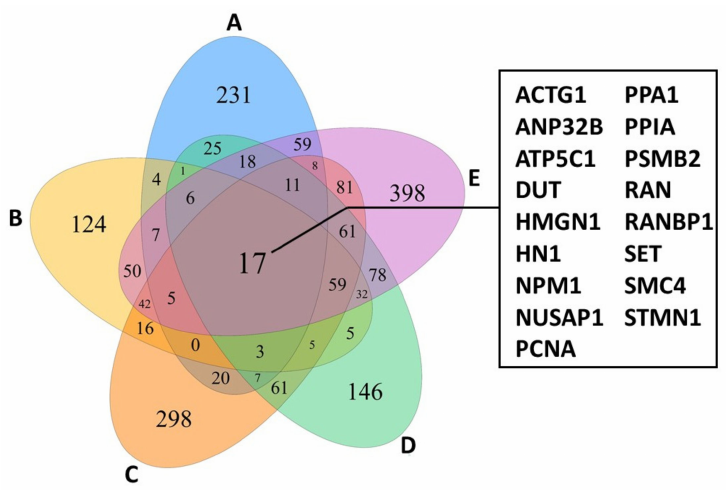
Figure 2. Venn diagram of proliferating lymphocytes from CTCL-lesions of 5 different patients ( A – E ) showing an overlap of 17 genes highly while only minor expression is observed in controls. The figure was created with specifications from